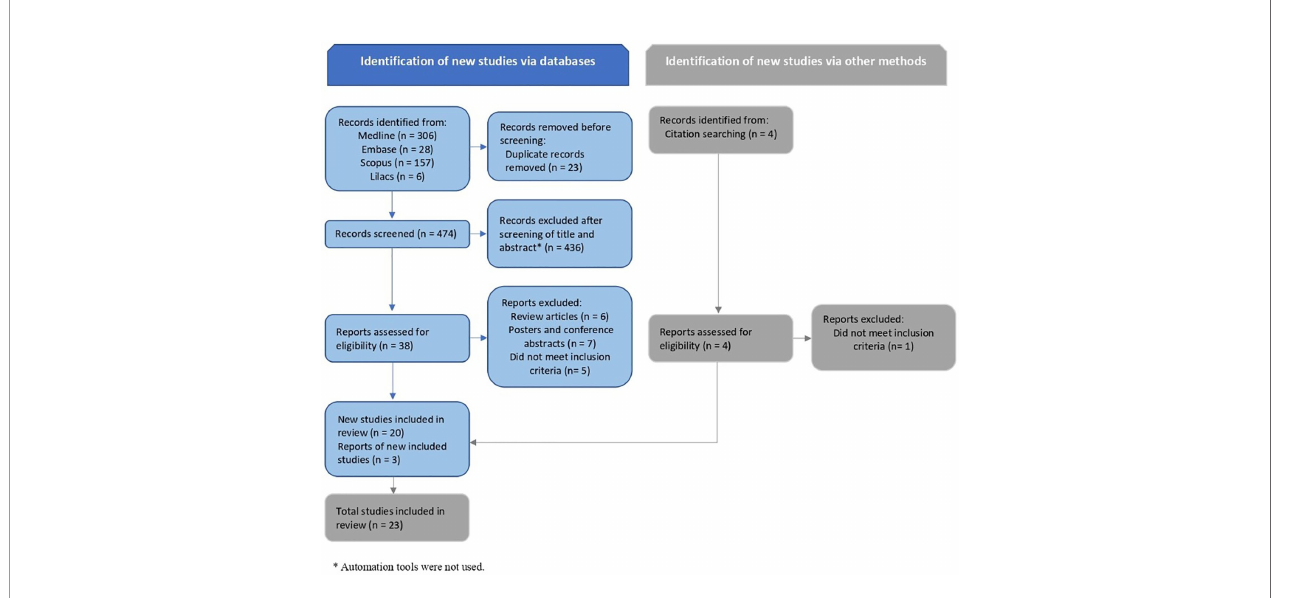
FIGURE 1 | PRISMA fl ow diagram of records identi fi cation, screening and